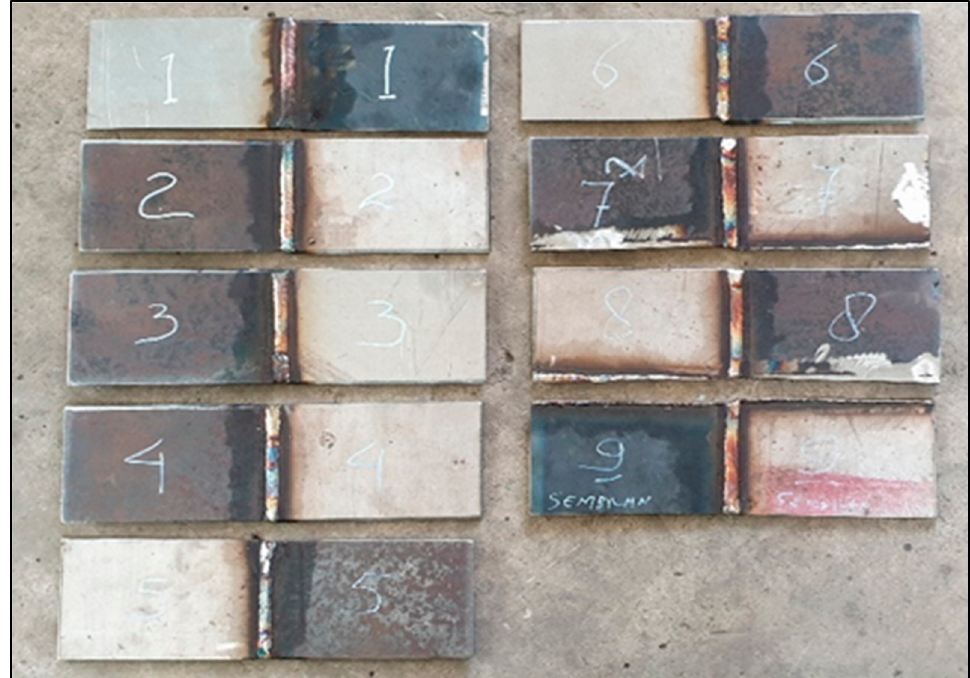
Figure 1. Weld joint appearance of SS316 (grey) and ASTM A36 (brownish). Specimen parts that do not pass the screening will not be used to produce